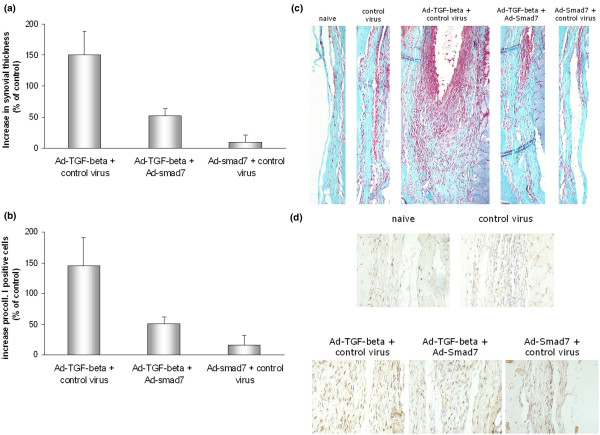
Synovial fibrosis was assessed in knee joints 2 weeks after intra-articular injection of Ad-transforming growth factor-β (TGF-β) combined with Ad-luciferase or Ad-Smad7. As a measure of fibrosis, the synovial width opposite the growth plates in the femur was measured (a) In addition, the amount of cells staining positive in immunohistochemically stained sections for procollagen type I was calculated with a computerized imaging system (b). The data are represented as an increase of the viral control. Histological representations of the measurements give an indication of actual thickness (c) and procollagen positive cells (d) There were no differences between viral and non-injected controls. TGF-β overexpression resulted in an increase in synovial thickness and number of procollagen type I-positive cells (p < 0.05). By co-expression with Smad7, most of the TGF-β-induced fibrosis was prevented (p < 0.05). Error bars display standard error.